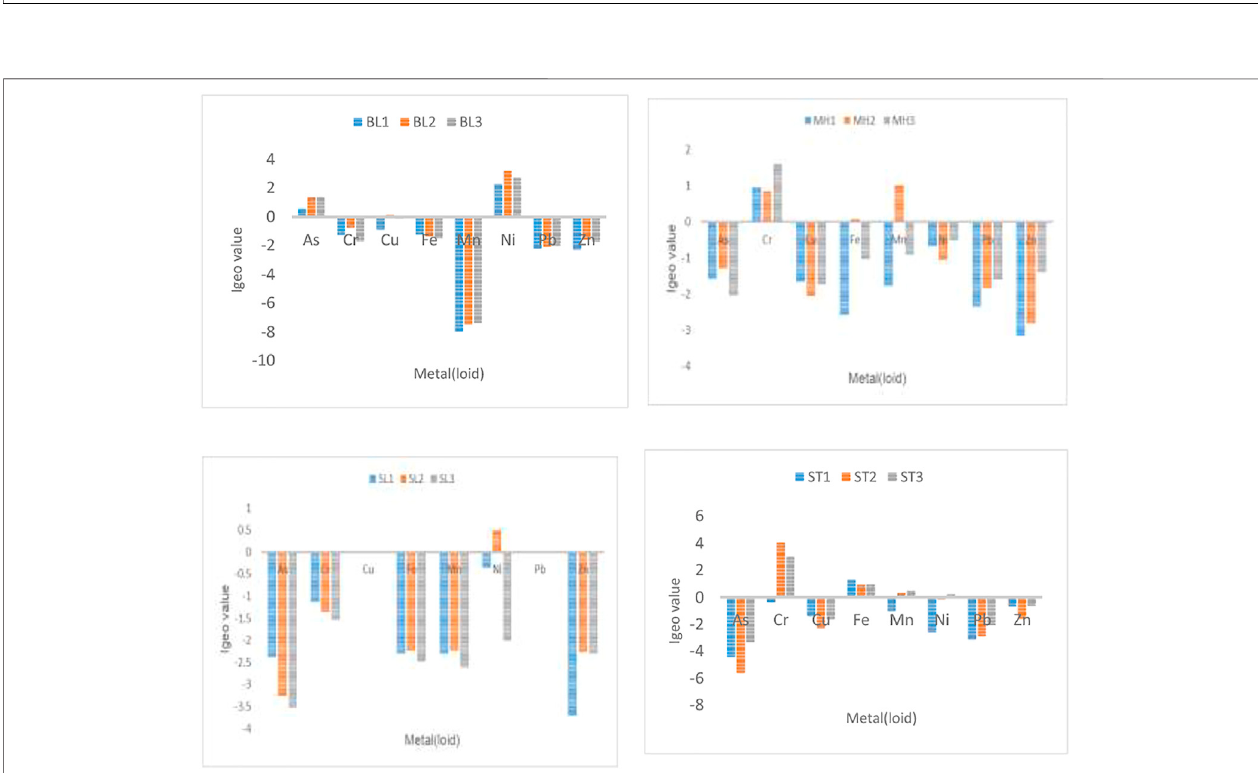
FIGURE 4 | Geo-accumulation index (Igeo) of metal(loid)s collected from different sites of the four rivers in the Olifants River Basin.